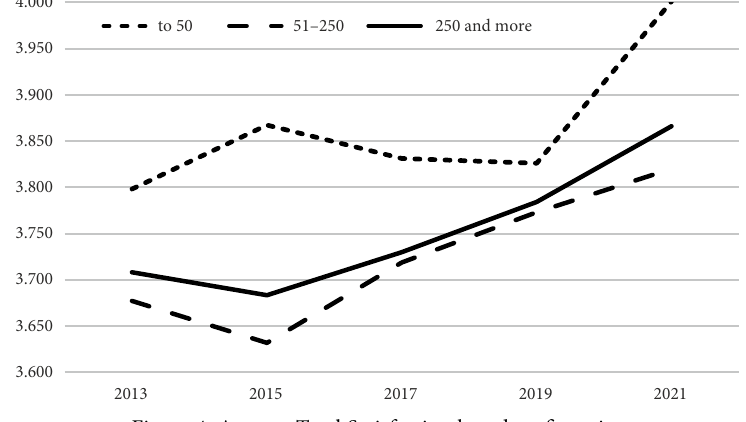
Figure 4. Average Total Satisfaction based on firm size (source: own